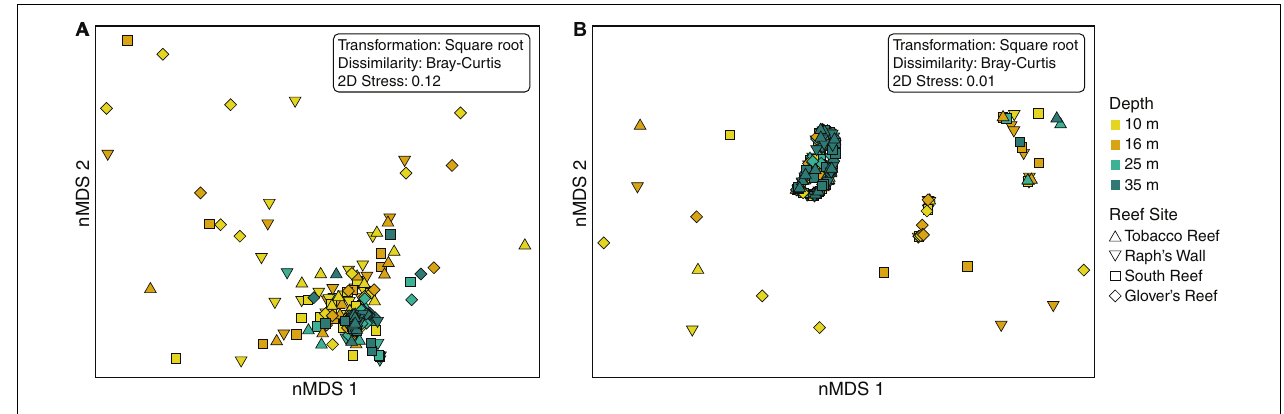
FIGURE 5 | Non-metric multidimensional scaling (nMDS) biplot based on (A) ITS2 sequences and (B) ITS2 type profiles using Bray-Curtis dissimilarities. Each point represents the Symbiodiniaceae found within a Montastraea cavernosa sample. Color denotes sampling depth and shape denotes reef site.